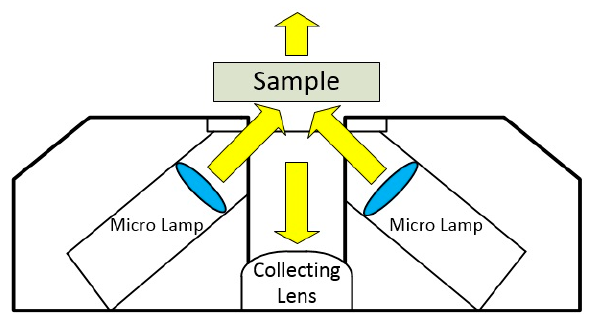
Figure 2. Method of performing measurements in reflectance